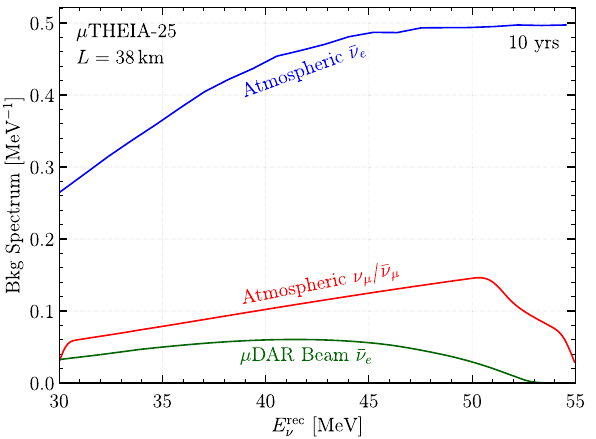
Fig. 7 The event spectra of μ DAR source at THEIA detector at base- line L = 38km. The Four solid lines are δ D = 0 ◦ (red), 90 ◦ (blue), 180 ◦ (green), and 270 ◦ (purple). The filled regions stand for the back- grounds the atmospheric ν e (blue), the atmospheric ν μ / ¯ ν μ (red) and the intrinsic ν e from the μ DAR beam